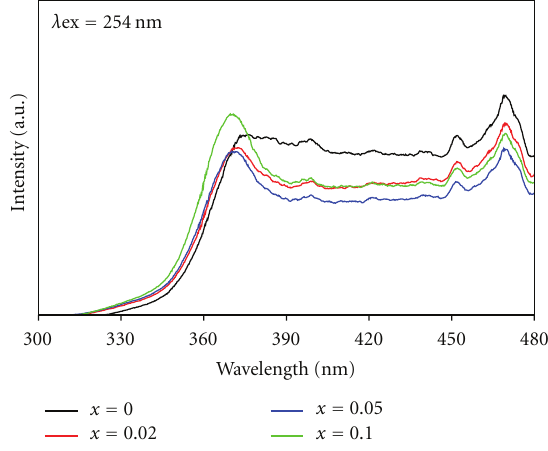
Figure 6: Di ff use reflectance spectra of SrTi 1 − x Ta x O 3 − y N y powders ( x = 0 − 0 . 1).